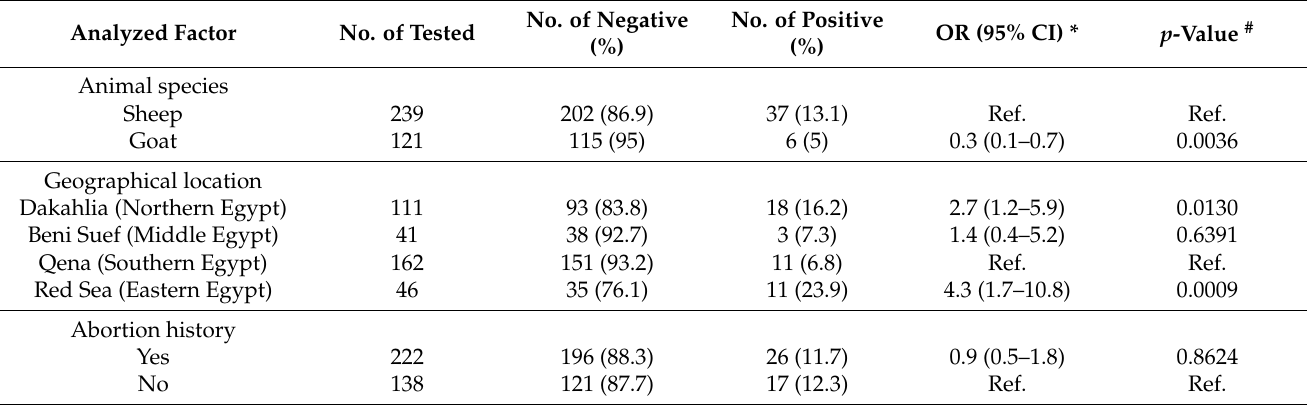
Table 5. Risk factors for N. caninum antibodies in sheep and goats in Egypt.